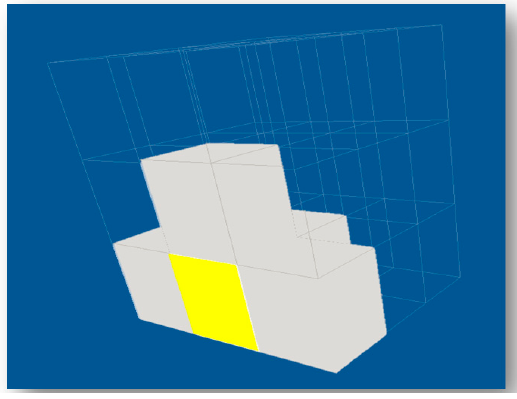
Figure 8. Neighboring objects that share common surfaces.